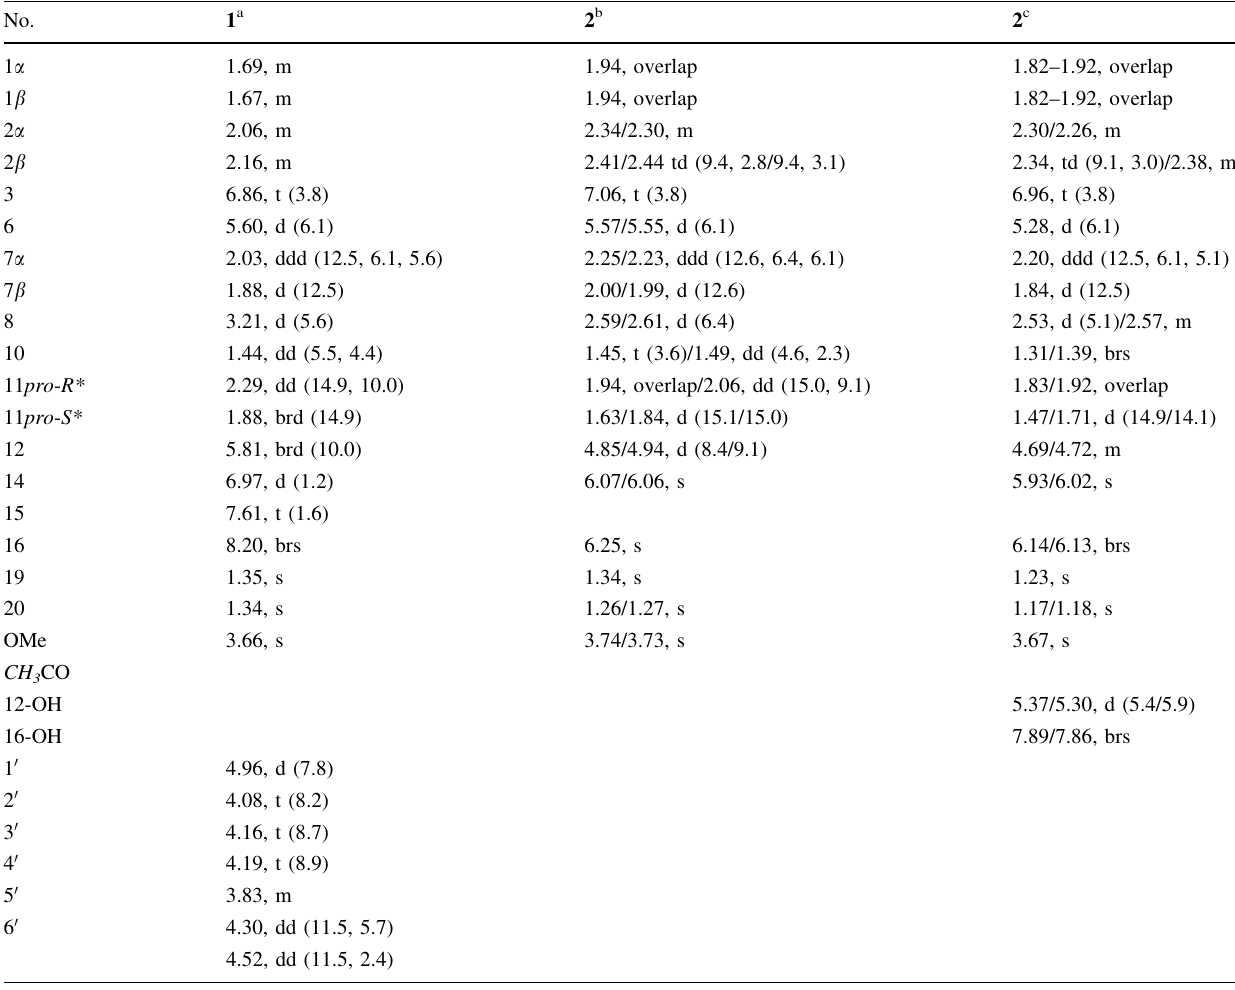
Table 1 1 H NMR spectroscopic data for 1 and